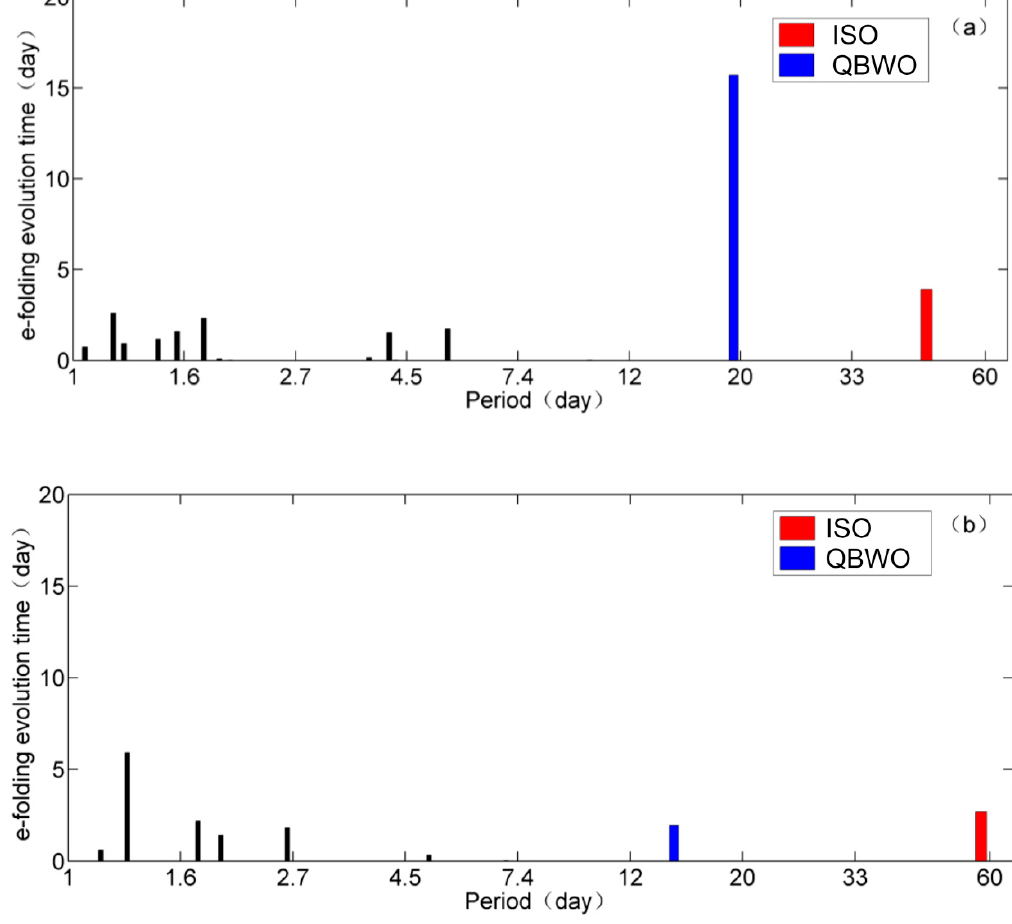
Figure 3. The e -folding time for perturbations of different temporal bands during the periods ( a ) 1948–1975 and ( b ) 1978–2009. The red and blue bars indicate the ISO and QBWO bands, respectively.